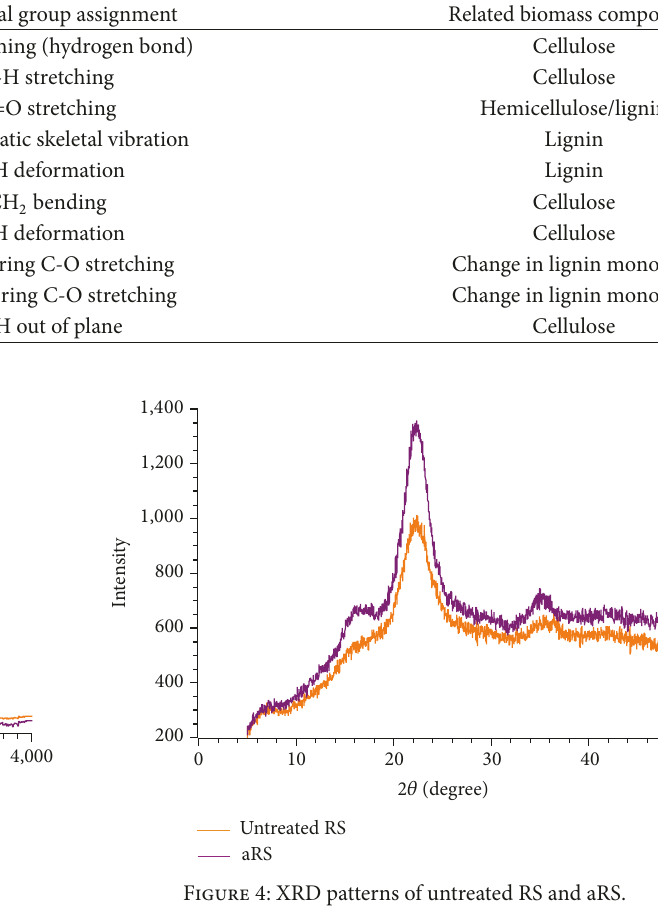
Table 2: Assignment and description of peaks corresponding to functional groups of biomass components by FTIR analysis.